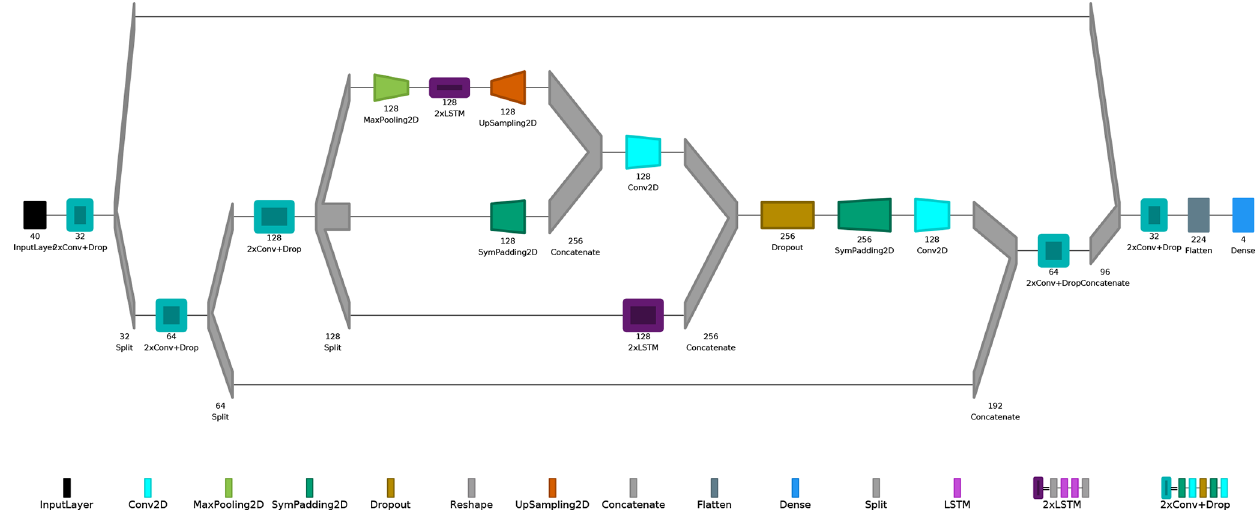
Figure 4. Summary of NN3s model architecture with input (black, left), hidden, and output (blue, right) layer. Several layers are grouped for better visualisations. Colour-coding of individual layers and groups is shown on the right. This figure was created with Net2Vis (Bauerle et al., 2021). Table 3. Naming of deep learning experiments and reference models described in this